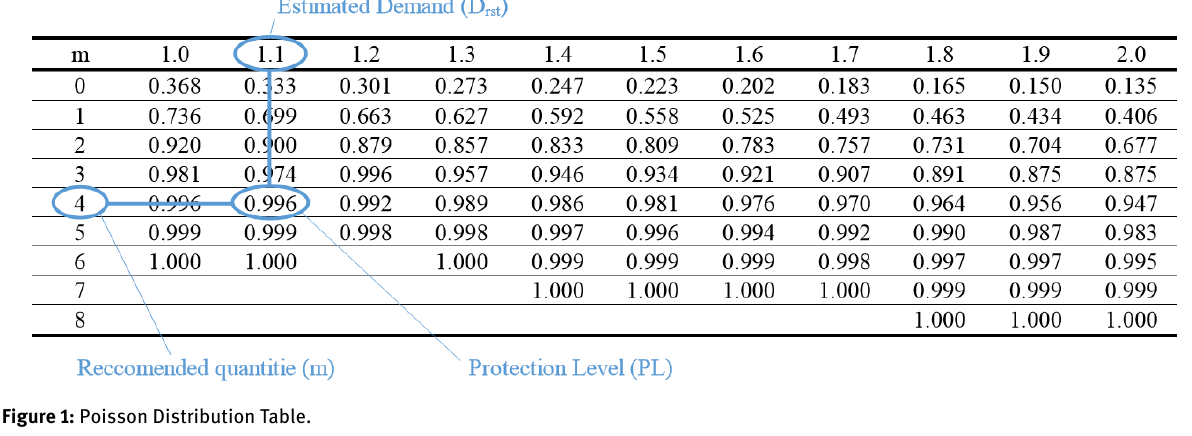
Figure 1: Poisson Distribution